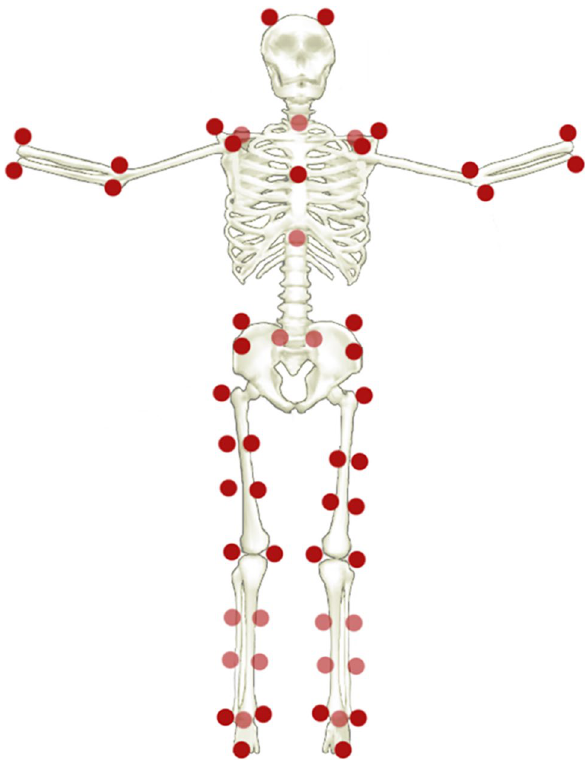
Figure 1. Marker set. Visual representation of the fifty-five markers positioned on the anatomical landmarks of feet, lower limb joints, pelvis, trunk, upper limb joints and